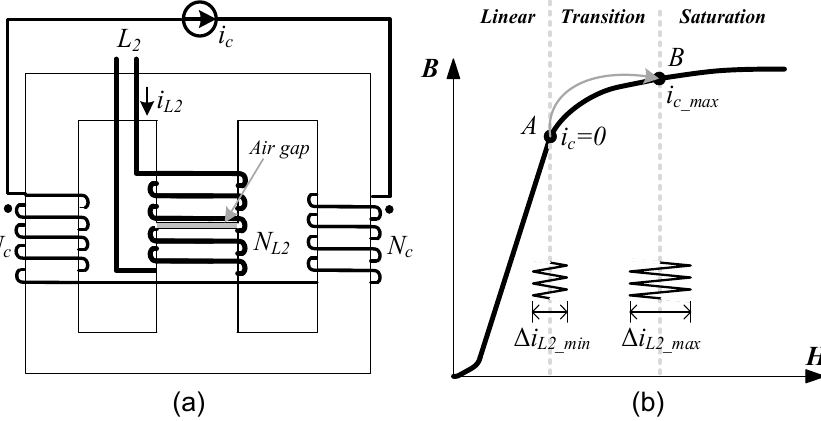
Figure 6. Complete VI model: ( a ) winding distribution; ( b ) operating points on B–H curve.